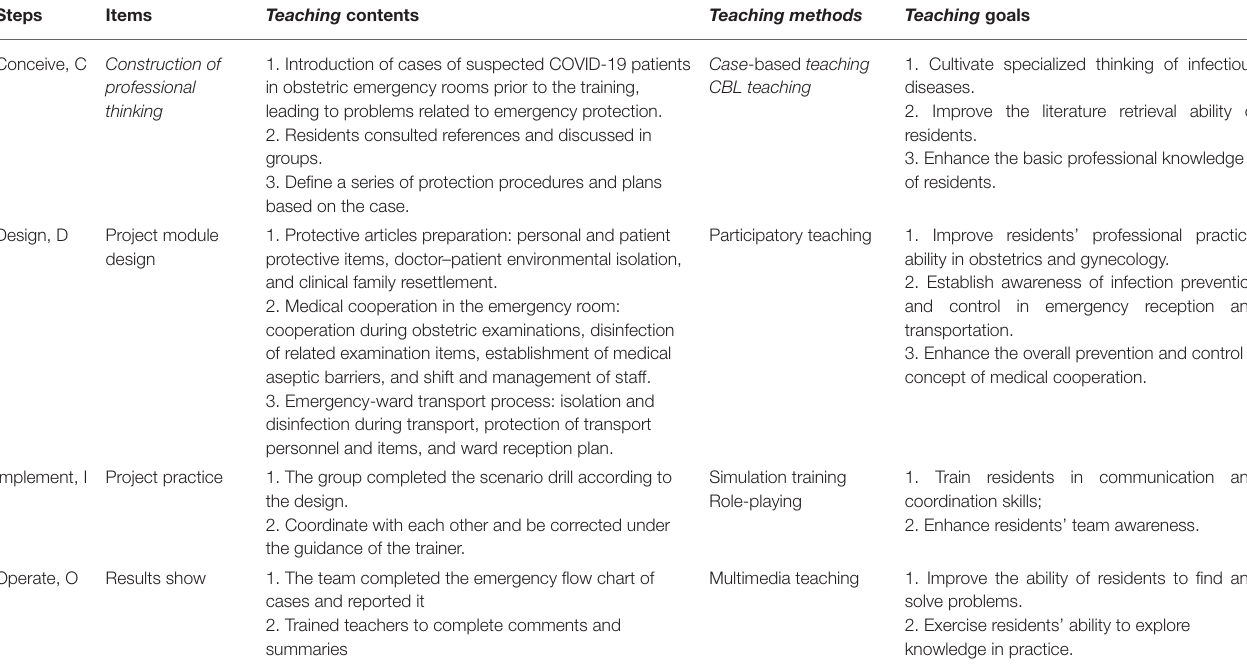
TABLE 2 | Epidemic prevention practice training programme for residents in the intervention group using the CDIO